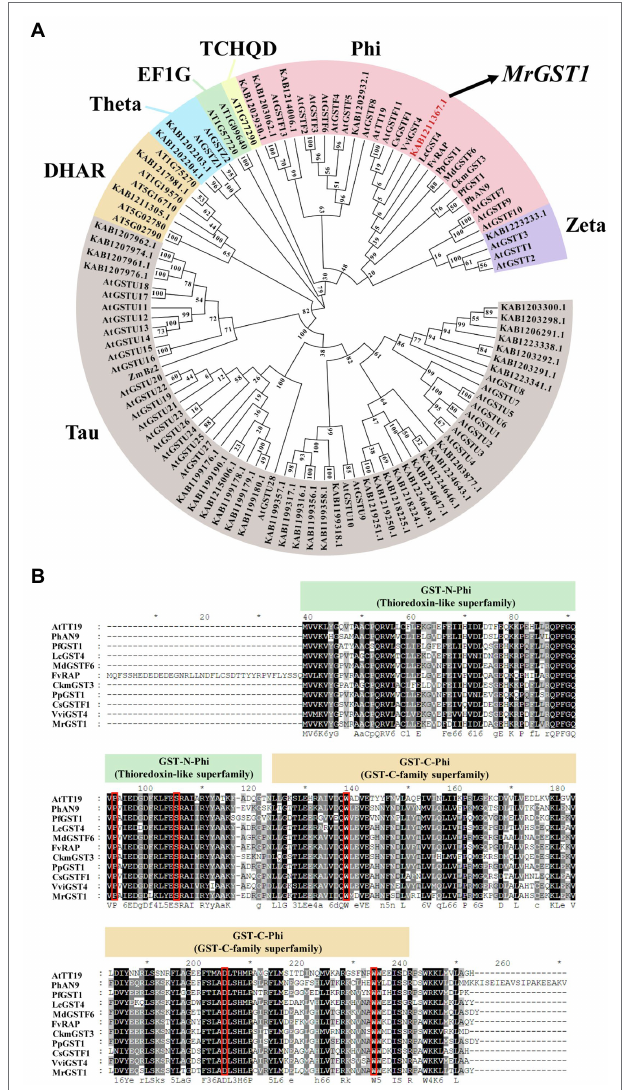
FIGURE 1 | Identification of anthocyanin-related glutathione S -transferases (GST) transporter from the Chinese bayberry ( Morella rubra ) genome. (A) Phylogenetic analysis of 105 GSTs based on deduced amino acid sequence, including 42 from Chinese bayberry, with names beginning with KAB, 53 from Arabidopsis, with names beginning with AT or At, as well as 10 from other plants with function characterized as anthocyanin transport related. Gene IDs are shown for genes from Chinese bayberry. The full-length amino acid sequences of GSTs family members of Arabidopsis were downloaded from The Arabidopsis Information Resource (TAIR, https://www. arabidopsis.org/). The accession numbers in NCBI are shown for others: PfGST1 ( Perilla frutescens , AB362191), CkmGST3 ( Cyclamen , AB682678), PhAN9 ( Petunia hybrida , Y07721), VviGST4 ( Vitis vinifera , AAX81329), CsGSTF1 ( Camellia sinensis , ABA42223), LcGST4 ( Litchi chinensis , KT946768), FvRAP ( Fragaria ananassa , gene31672), PpGST1 ( Prunus persica , Prupe.3G013600), MdGSTF6 ( Malus domestica , MD17G1272100), ZmBz2 ( Zea mays , NP_001183661.1). The member KAB1211367.1 is denoted as MrGST1 in this study. (B) Protein sequence alignment of MrGST1 (KAB1211367.1) and anthocyanin-related GSTs from other dicotyledonous plants. Numbers in the alignments showed amino acid positions. Red boxes denoted amino acid residues previously identified as high-homology locations in the GST family (Alfenito et al.,